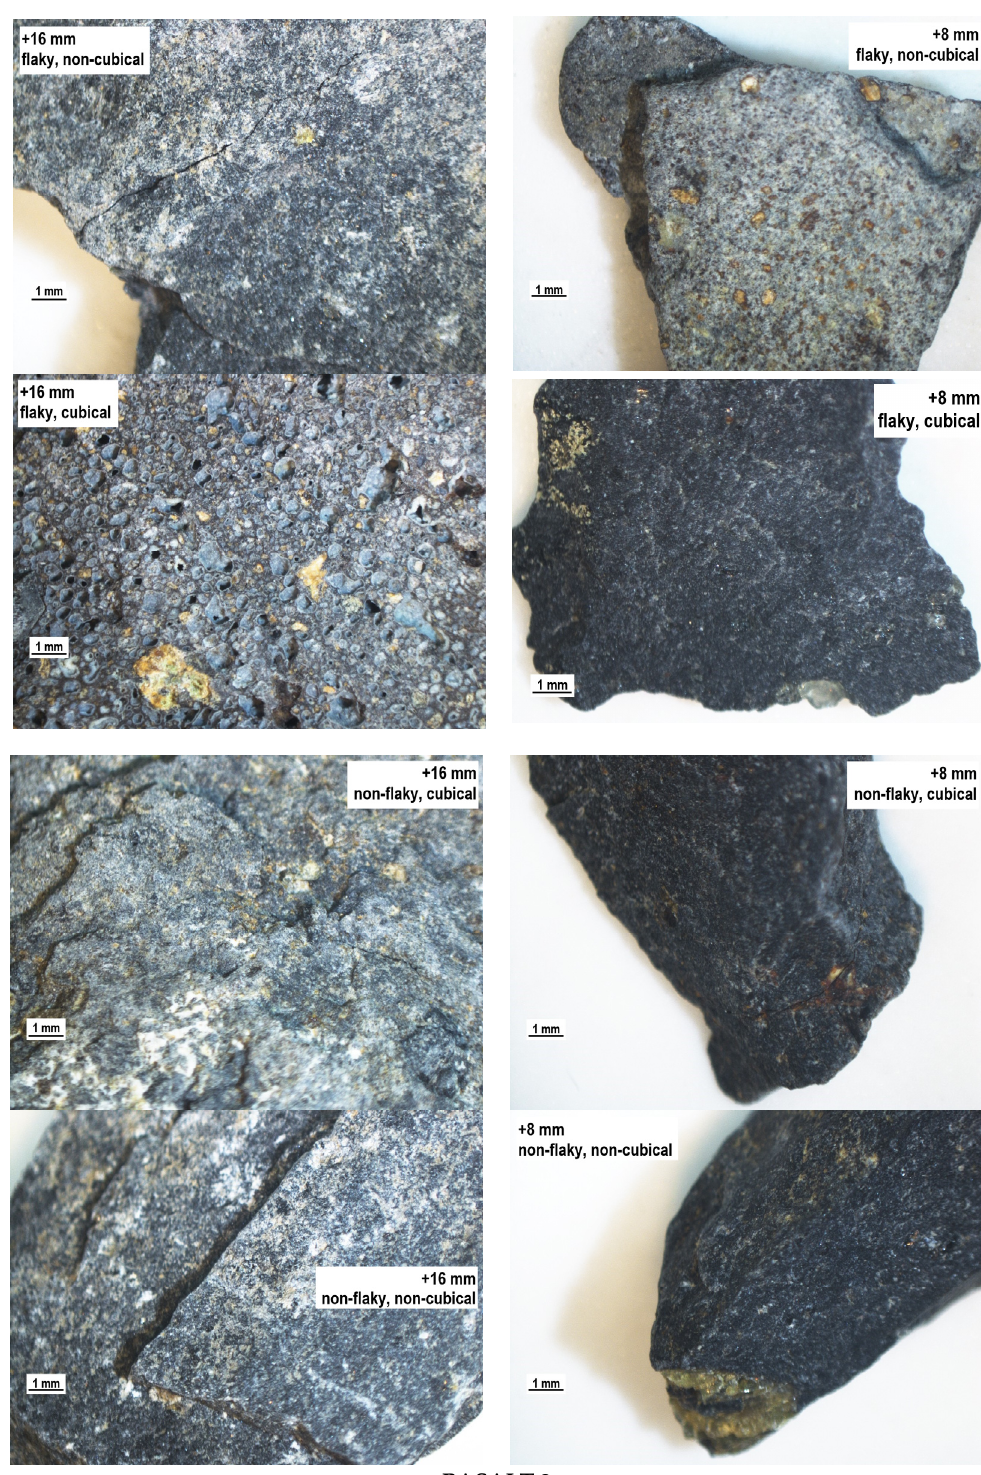
Figure 8. The structure of the particles of the basalt 2 aggregate, separate for the shape and particle size. The granite aggregate (Figure 9) has a low content of fractures in both of the analyzed size fractions. The fractures were mainly related to the structure of the mica minerals. The flaky thin particles were observed to be more prone to fractures.